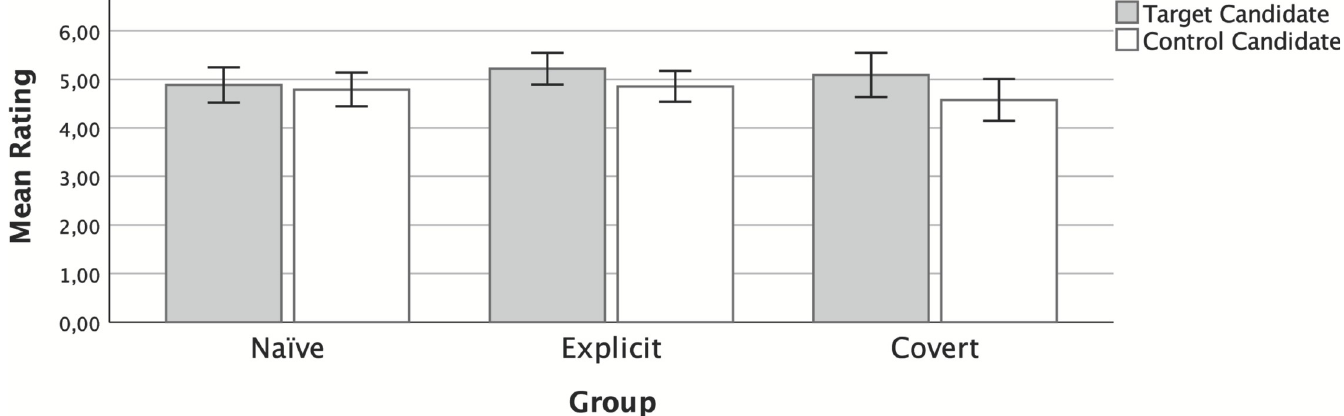
Fig 2. Mean preference for target and control candidates, in the explicit, covert, and no recommendation (na ï ve) groups in Experiment 3. Error bars represent 95% CI.